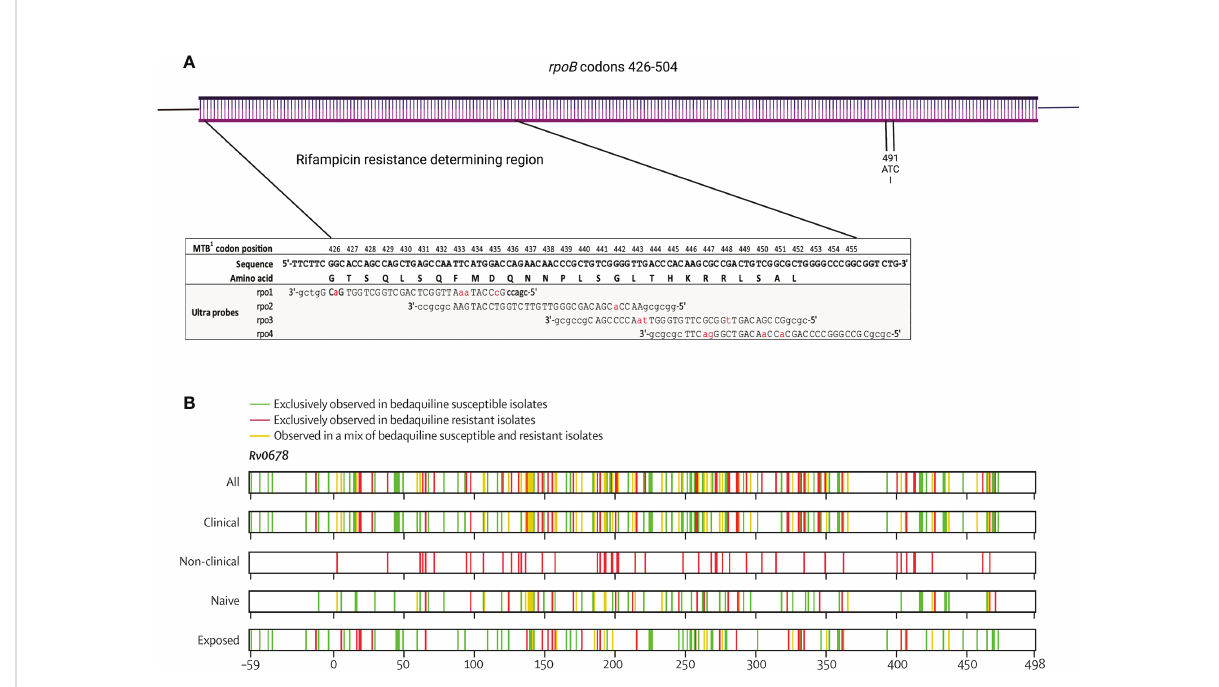
FIGURE 4 Schematic diagrams of (A) rpoB gene codons 426-504 showing rifampicin resistance determining region, coverage of Xpert MTB/RIF probes (modi fi ed from (Chakravorty et al., 2017) under CC BY 4.0 licence) and location of I491 codon, and (B) Rv0678 gene showing distribution of reported gene substitutions, coloured by association with resistance (reproduced from (Ismail et al., 2021) under CC BY 4.0